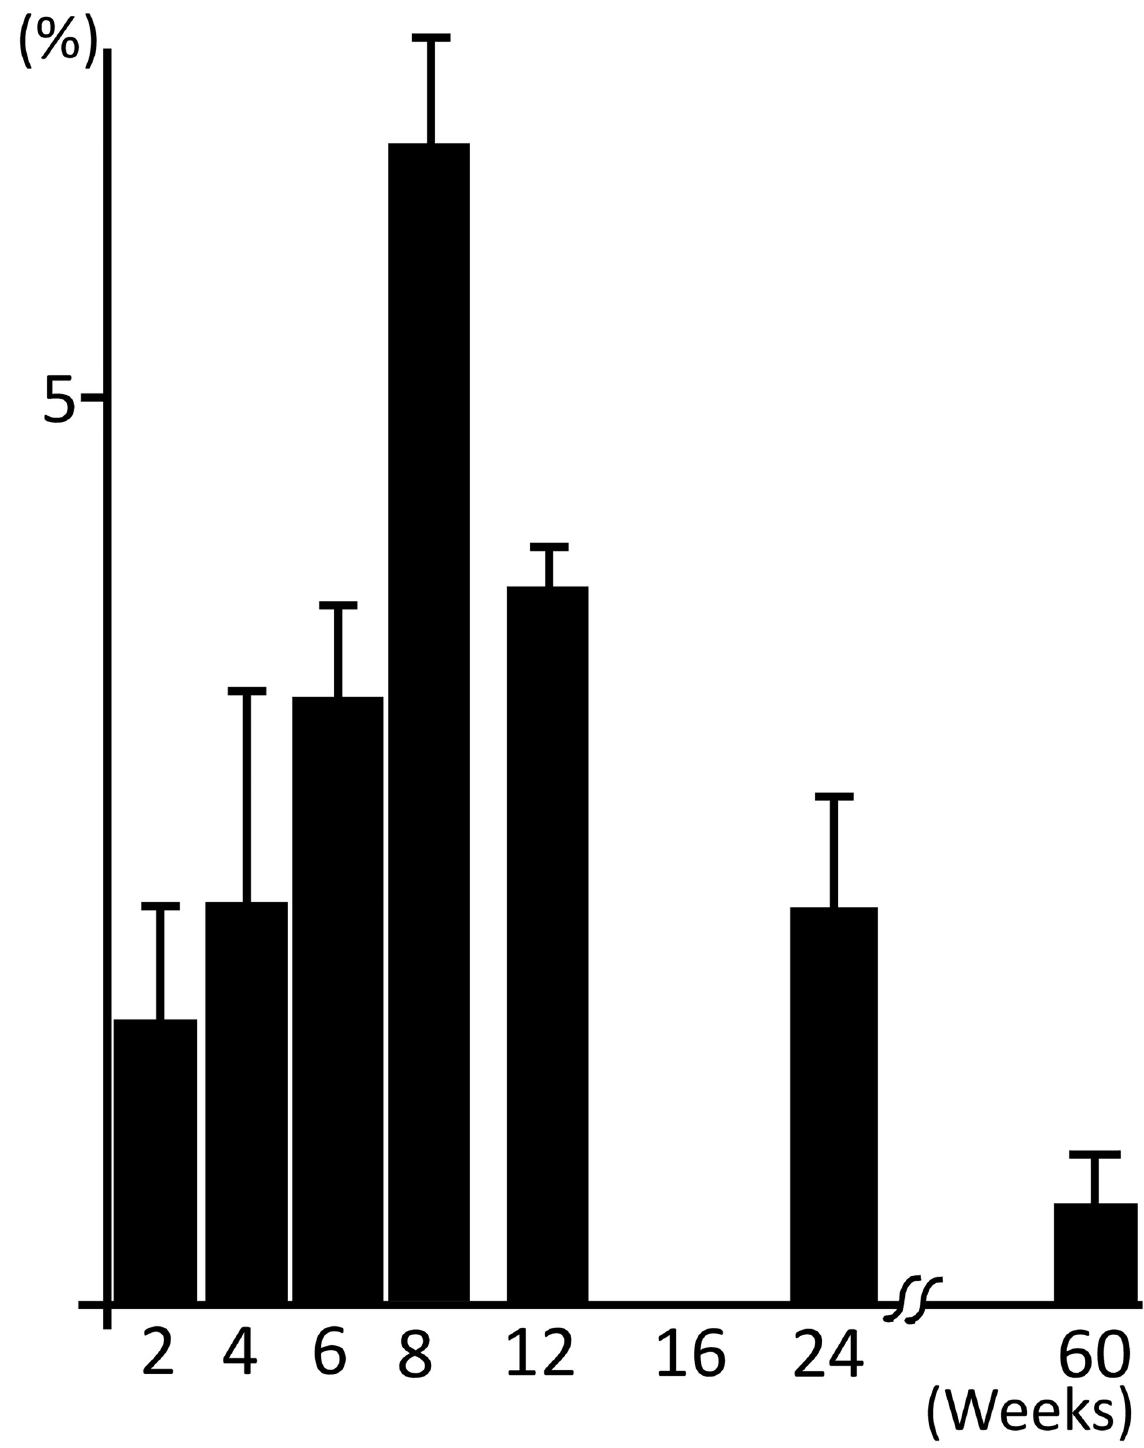
Fig 6. The numbers of DRG neurons covered with satellite cells showing strong GPR37L1 staining were counted, and the percentages for each postnatal week are shown. The peak occurred at 8 weeks.